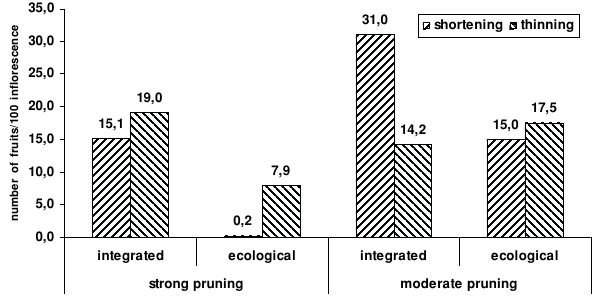
Figure 1. Effect of different pruning techniques on fruit set of ‘Idared’ apple trees grafted upon M 26 rootstock in the integrated as well as in ecological growing system (Debrecen-Pallag, 2008)